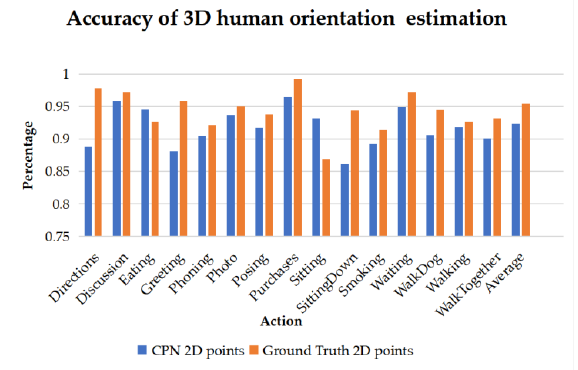
Figure 14. The result will be counted when F points to the shaded area.